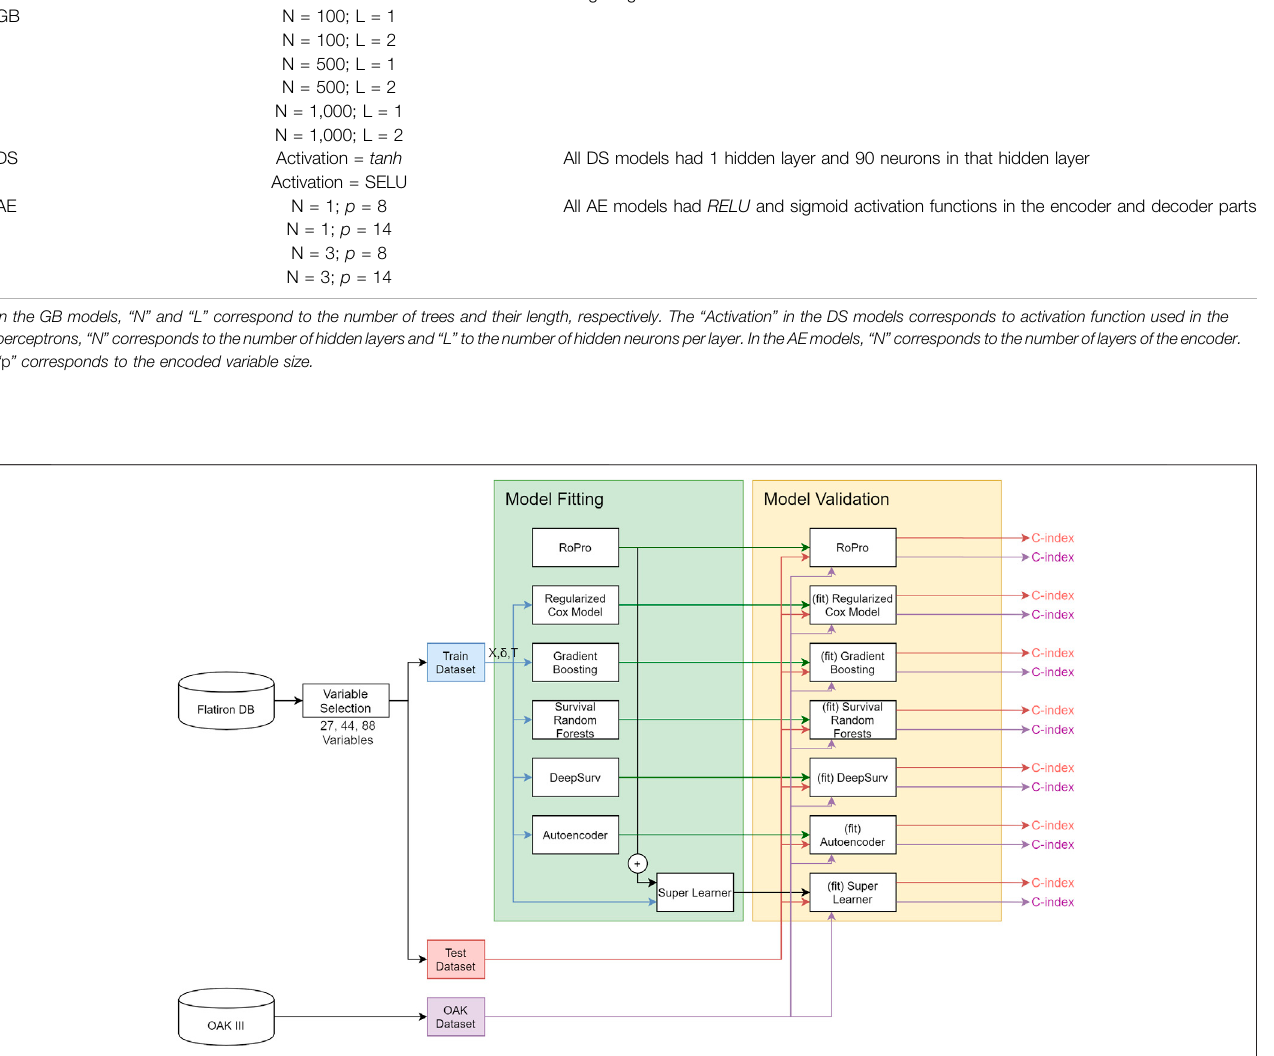
FIGURE 1 | Diagram of the